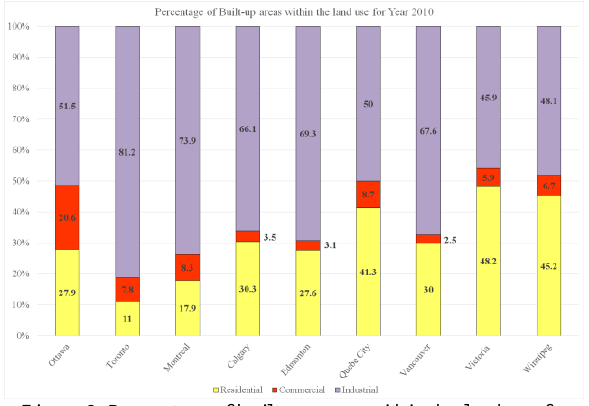
Figure 2. Percentage of built-up areas within the land use for